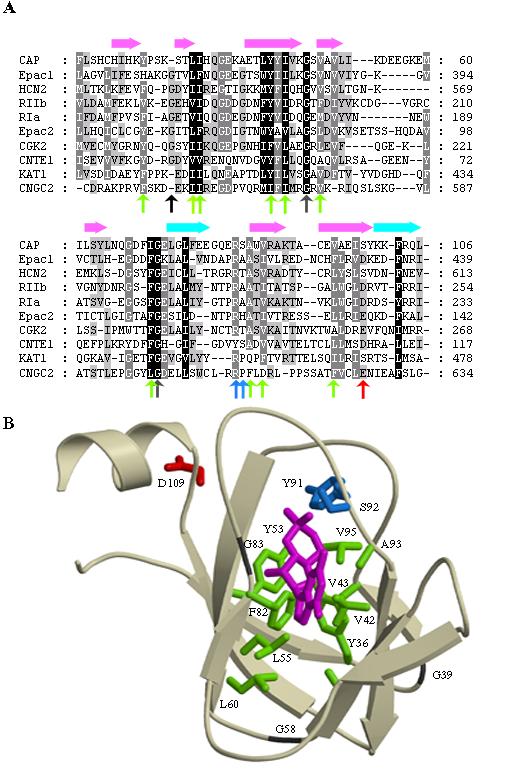
Analysis of plant CNB domains. (A) Arabidopsis CNB domains (CNTE1, KAT1 and CNGC2) were aligned against several well studied CNB domains including regulatory subunits of PKA (RIα and RIIβ), Epac1, Epac2, and cyclic GMP dependent kinase 2 (CGK2) from humans, HCN2 from mouse and E. coli CAP. Highlighted on the alignment are glycine residues involved in loop structures (dark grey arrows), residues forming the hydrophobic pocket for cNMP binding (green arrows) and residues proposed to contact the phosphate of the cNMP (blue arrows). The highly conserved helix capping acidic residue is shown in red. Secondary structure is denoted by arrows above the alignment, with light blue for alpha helices and pink for beta sheets and is based on the secondary structure of HCN2. (B) A homology model of atCNTE1 was generated from the known structures of CNB domains. Key residues are shown as stick representations and are colored and labeled according to the color scheme described in (A). The cGMP ligand is shown in magenta and is based on the structure of cGMP bound to HCN2 [pdb: 1Q3E] superimposed over our model. Figure was generated with Molscript [83] and Raster3D [84].